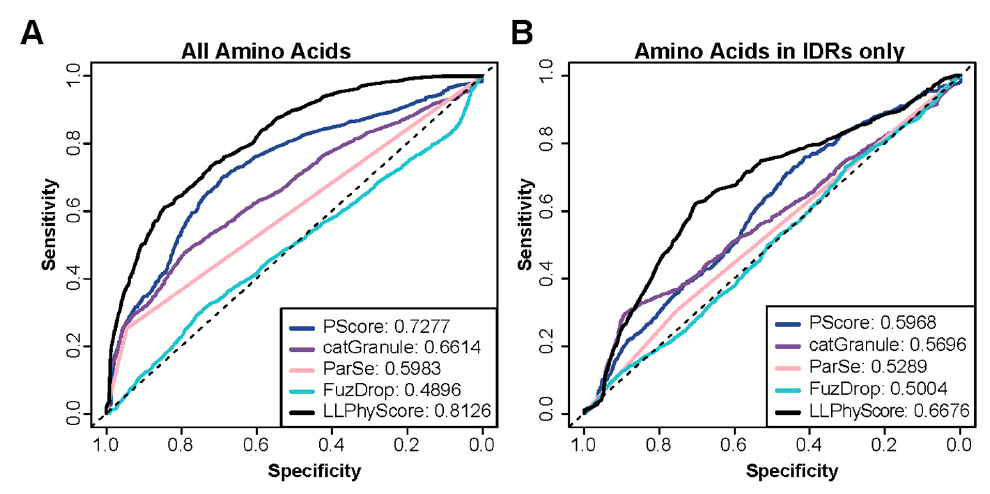
Figure 3. Performance of state-of-the art methods on residue-level prediction of segments involved in phase separation. ( A , B ) ROC curves calculated with predictions by catGranule, FuzDrop, Parse, PScore and LLPhyScore. AUC values are provided for each method in the legend. ( A ) Curves are calculated using all residues in protein segments identified experimentally to be involved in phase separation as positives (PR) and all remaining residues of the same proteins as negatives (NR). ( B ) Curves are calculated using only those residues in PR and NR that are part of predicted intrinsically disordered regions (IDRs).